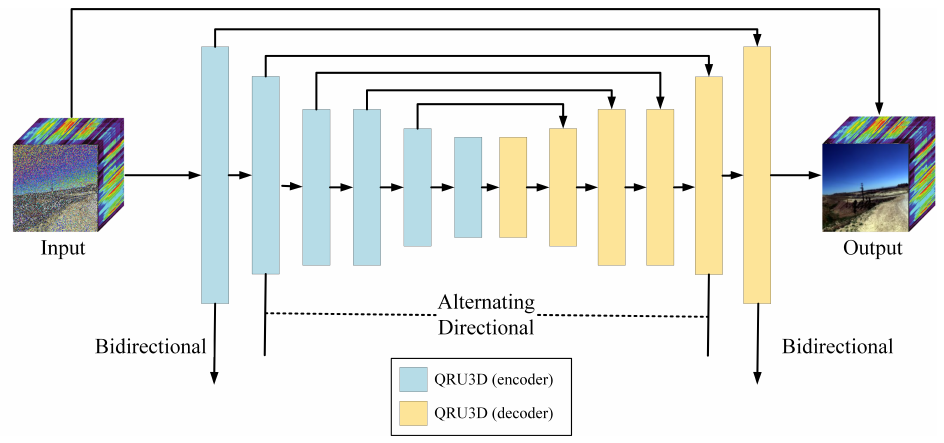
Figure 13. Structure of QRNN3D